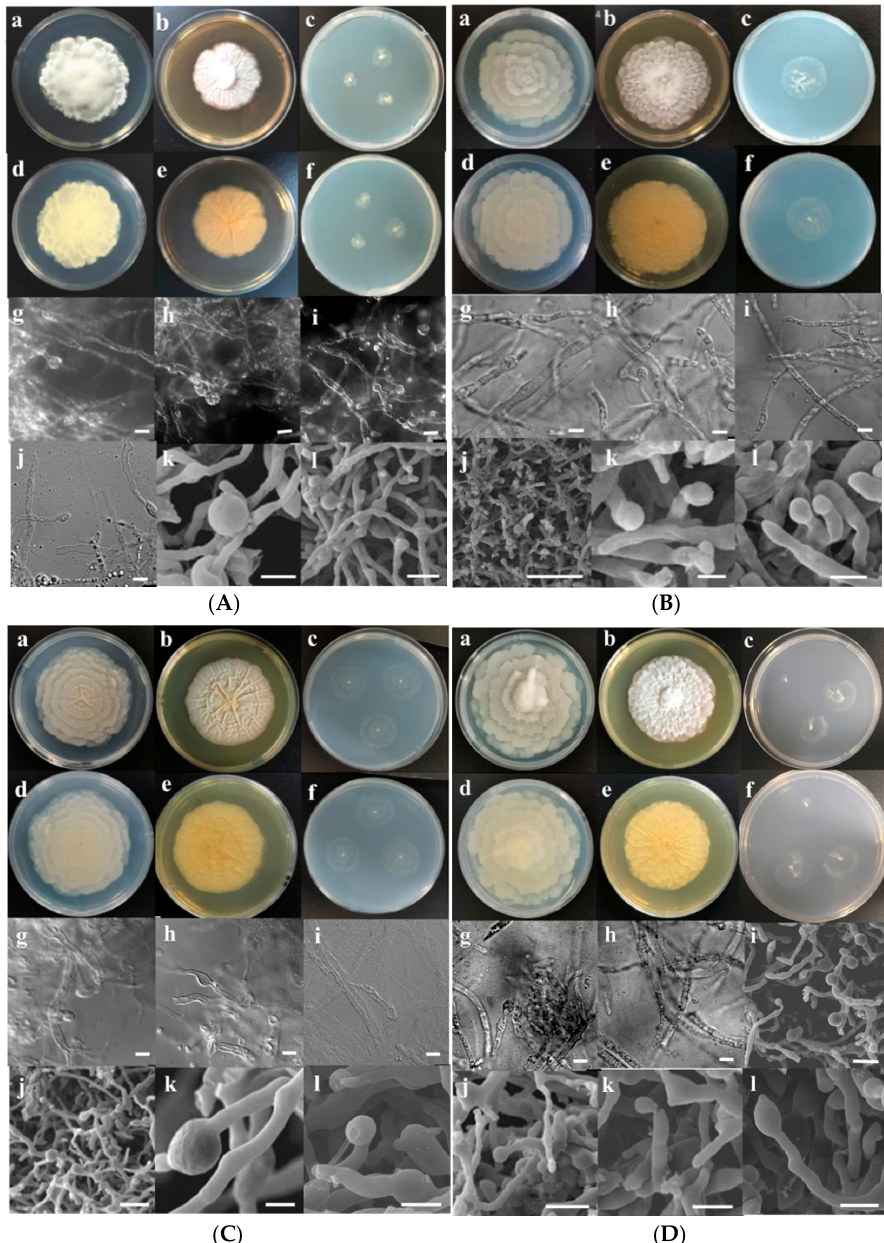
Figure 2. Morphology of the fungal isolates. ( A ) L3. Colonies grown on different media after 7 days at 30 °C, a–c: left to right, obverse PDA, MEA, and SNA. d–f: left to right, reverse PDA, MEA, and SNA. g–l: Microscopic and scanning electron microscopy of sporangia (scale bars: g–j, 20 μ m; k, 5 μ m; l, 10 μ m). ( B ) L4. Colonies grown on different media after 7 days at 30 °C, a–c: left to right, obverse PDA, MEA, and SNA. d–f: left to right, reverse PDA, MEA, and SNA. g–l: Microscopic and scanning electron microscopy observation of sporangia (scale bars: g–i, 20 μ m; j, 30 μ m; k–l, 5 μ m). ( C ) L5. Colonies grown on different media after 7 days at 30 °C, a–c: left to right, obverse PDA, MEA, and SNA. d–f: left to right, reverse PDA, MEA, and SNA. g–l: Microscopic and scanning elec ‐ tron microscopy of sporangia (scale bars: g–i, 20 μ m; j, 20 μ m; k–l, 5 μ m). ( D ) L12. Colonies grown on different media after 7 days at 30 °C, a–c: left to right, obverse PDA, MEA, and SNA. d–f: left to right, reverse PDA, MEA, and SNA. g–l: Microscopic and scanning electron microscopy of sporan ‐ gia (scale bars: g–i, 20 μ m; j, 10 μ m; k–l, 5 μ m). L4: The colony diameter reached 61–63 mm after 7 days of cultivation on MEA. White cotton ‐ like mycelia in the middle of the colony surface extended in all directions to form petal ‐ like folds. After 7 days culture on PDA, the diameter of the strain reached 65–67 mm. The colony growth rate on SNA was slower than that on PDA and MEA. The diameter of the colony growing on SNA reached 28 mm after 7 days, and aerial mycelia were dis ‐ persed on the agar surface (Figure 2B). Sporogenesis was abundant with single ‐ ended sporangium. Sporangia were spherical and 1.3–4.2 × 1.3–3.4 μ m in size. Sporangia were globose to subglobose. No zygospores were seen (Figure 2B). L5: The colony on PDA grew moderately fast, and the diameter reached 60–64 mm after 7 days of incubation at 30 °C. The front and back of the colony were white. As time goes on, the front side of the colony formed a concentric pattern like a flower; the reverse side of the colony turned slightly yellow and was irregularly zonate. The colony growth rate on MEA was slightly lower than that on PDA. After 7 days of culture at 30 °C, the colony diameter reached 55–57 cm. The colony grew slowly on SNA, and the diameter was only 22–28 mm after 7 days. Colonies were lighter in color and formed concentric patterns like flowers (Figure 2C). Sporangia were spherical and measured 2.6–5.5 × 2.2– 4.6 μ m. No zygospores were found (Figure 2C). L12: The strain grew very fast on PDA; after 7 days of culture at 30 °C, the colony diameter was 75–79 mm with a cotton ‐ like center and white edge. The opposite side of the colony gradually became yellowish ‐ white. After 7 days of culture at 30 °C on MEA, the